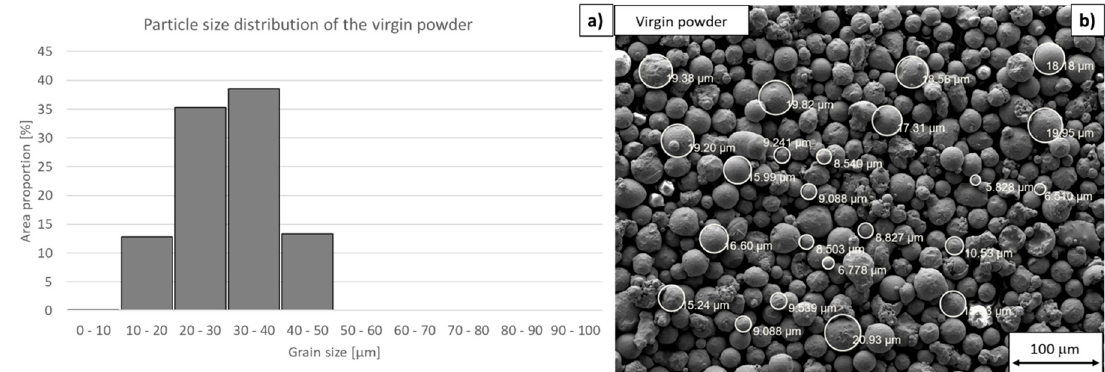
Figure 3. Virgin powder. ( a ) Particle size distribution (using the ImageJ software, 130 particles were measured for statistical significance), ( b ) tentative particle size measurement in a scanning electron micrograph using the SmartTiff software.